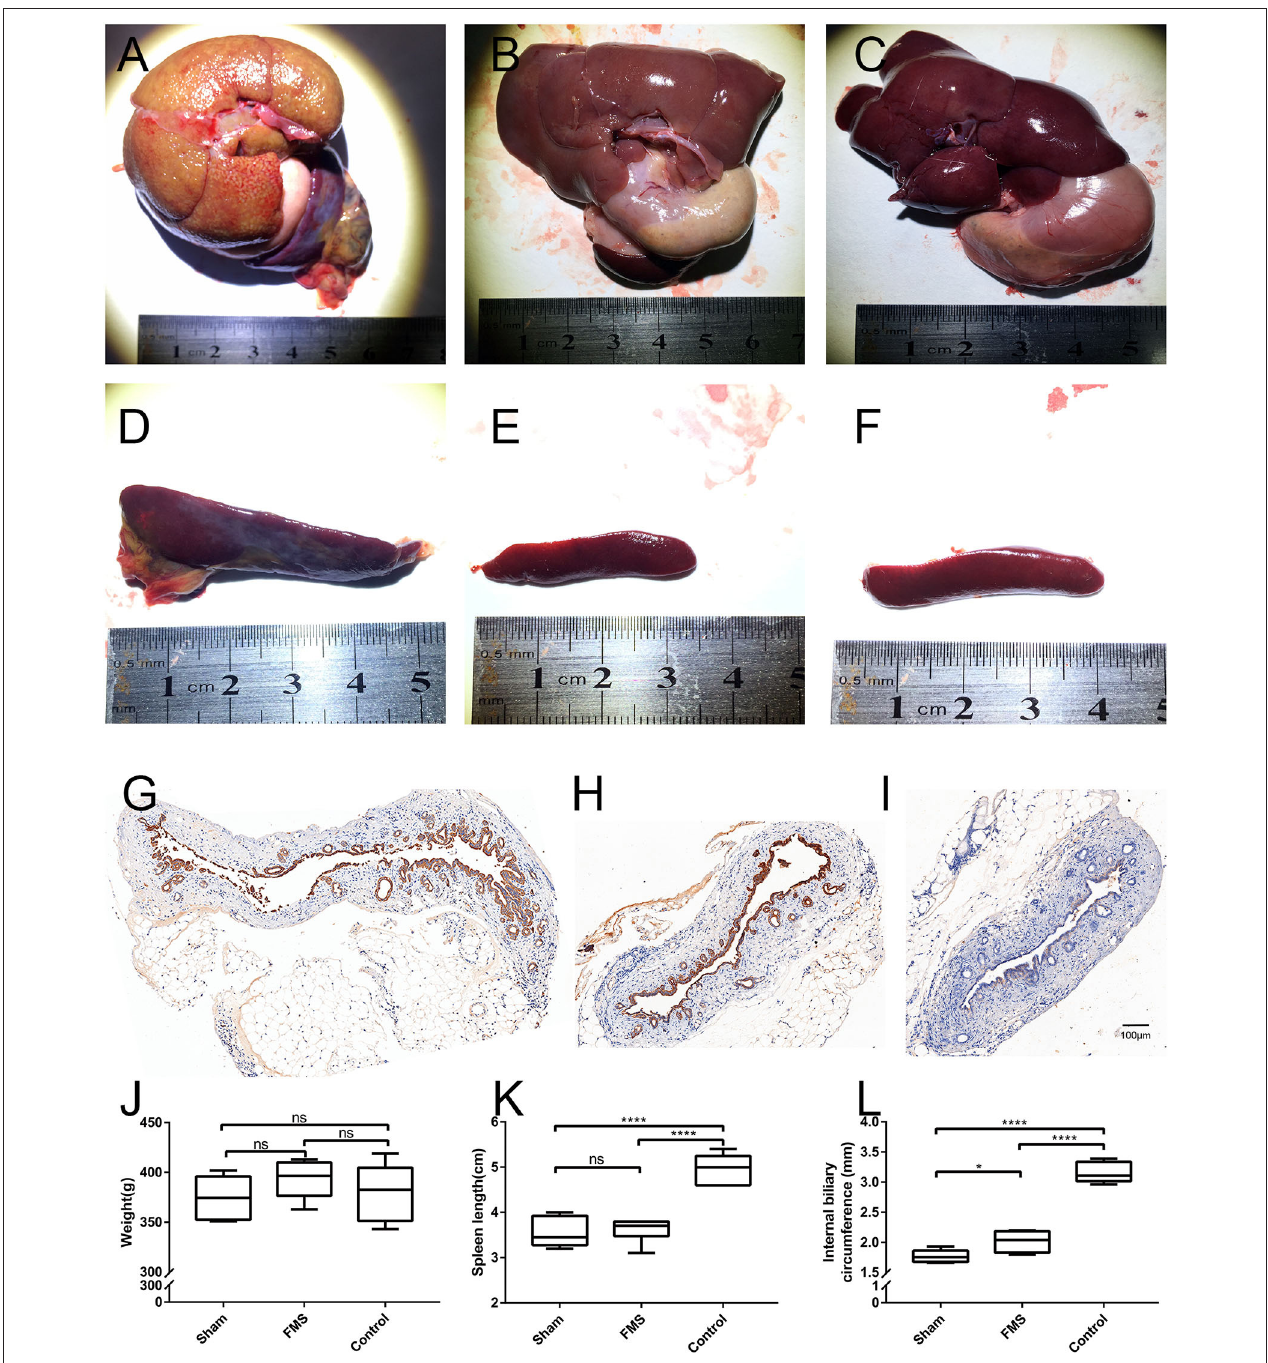
FIGURE 3 | The FMS reconstruction relieves the incidence of benign biliary stricture in vivo . The liver, spleen, and proximal bile duct were obtained after the rats were sacrificed. The liver in the control group (A) showed visible cholestasis, jaundice compared with the FMS group (B) and sham group (C) . Splenomegaly was found in the control group (D) , however, no significant differences were seen in the FMS group (E) and sham group (F) . The length of the spleen was compared (K) , the FMS reconstruction could relieve splenomegaly compared with the traditional anastomosis method. The proximal duct was transversely sliced and stained with a CK19 antibody. The internal biliary circumference was measured using Aperio ImageScope (L) . A significantly dilated bile duct was identified in the control group (G) . there is only mild dilatation of the bile duct in the FMS group (H) compared with the control group (I) . **** P < 0.0001.